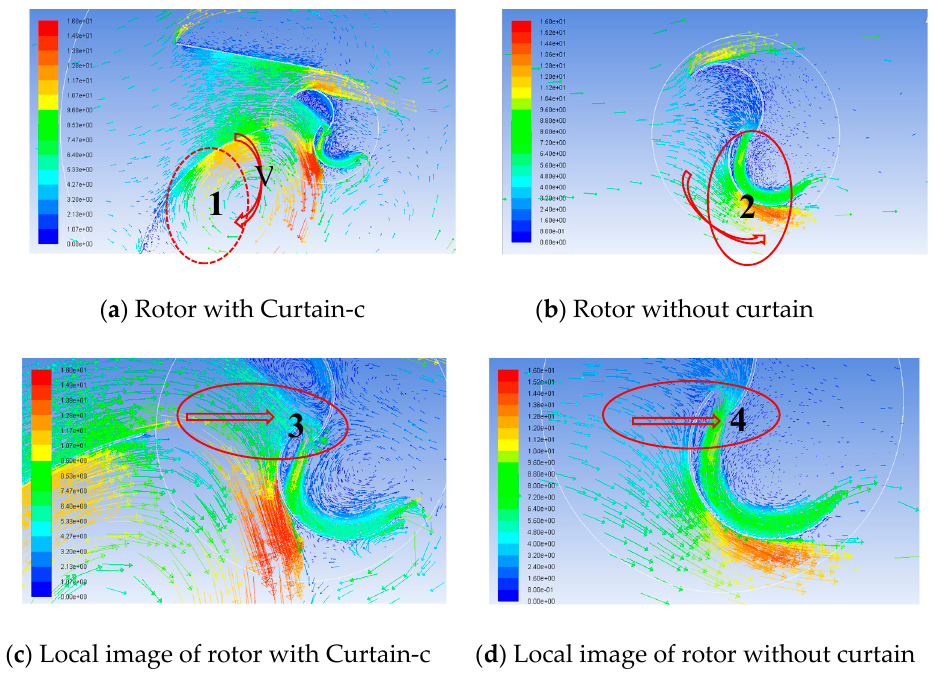
Figure 20. Comparison of the velocity contours for the wind rotor ( a ) with Curtain-c, ( b ) without the curtain and their corresponding local images ( c , d ) at θ = 45°.